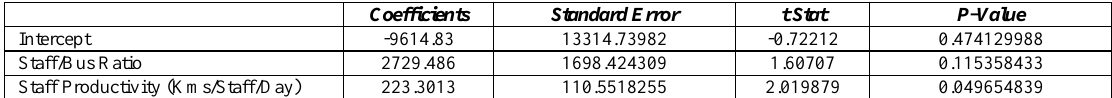
Table 6. Regression analysis for total staff